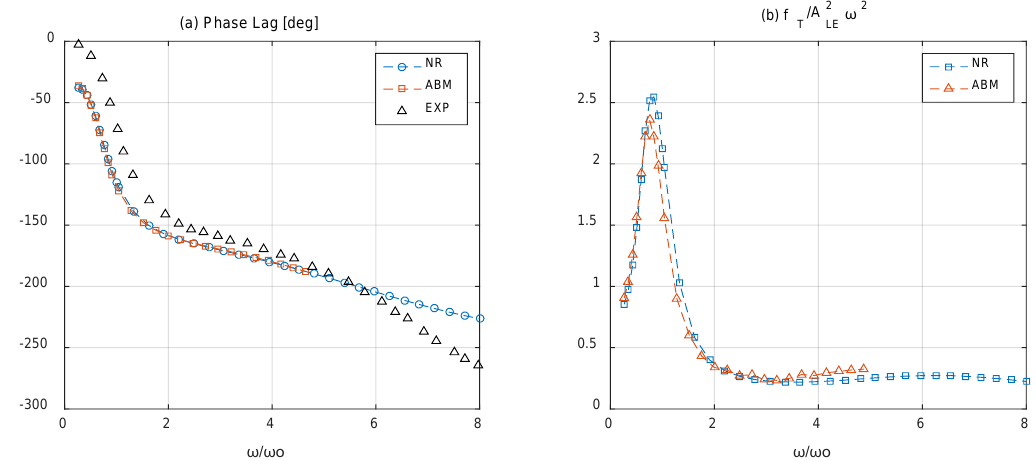
added for illustration purposes.